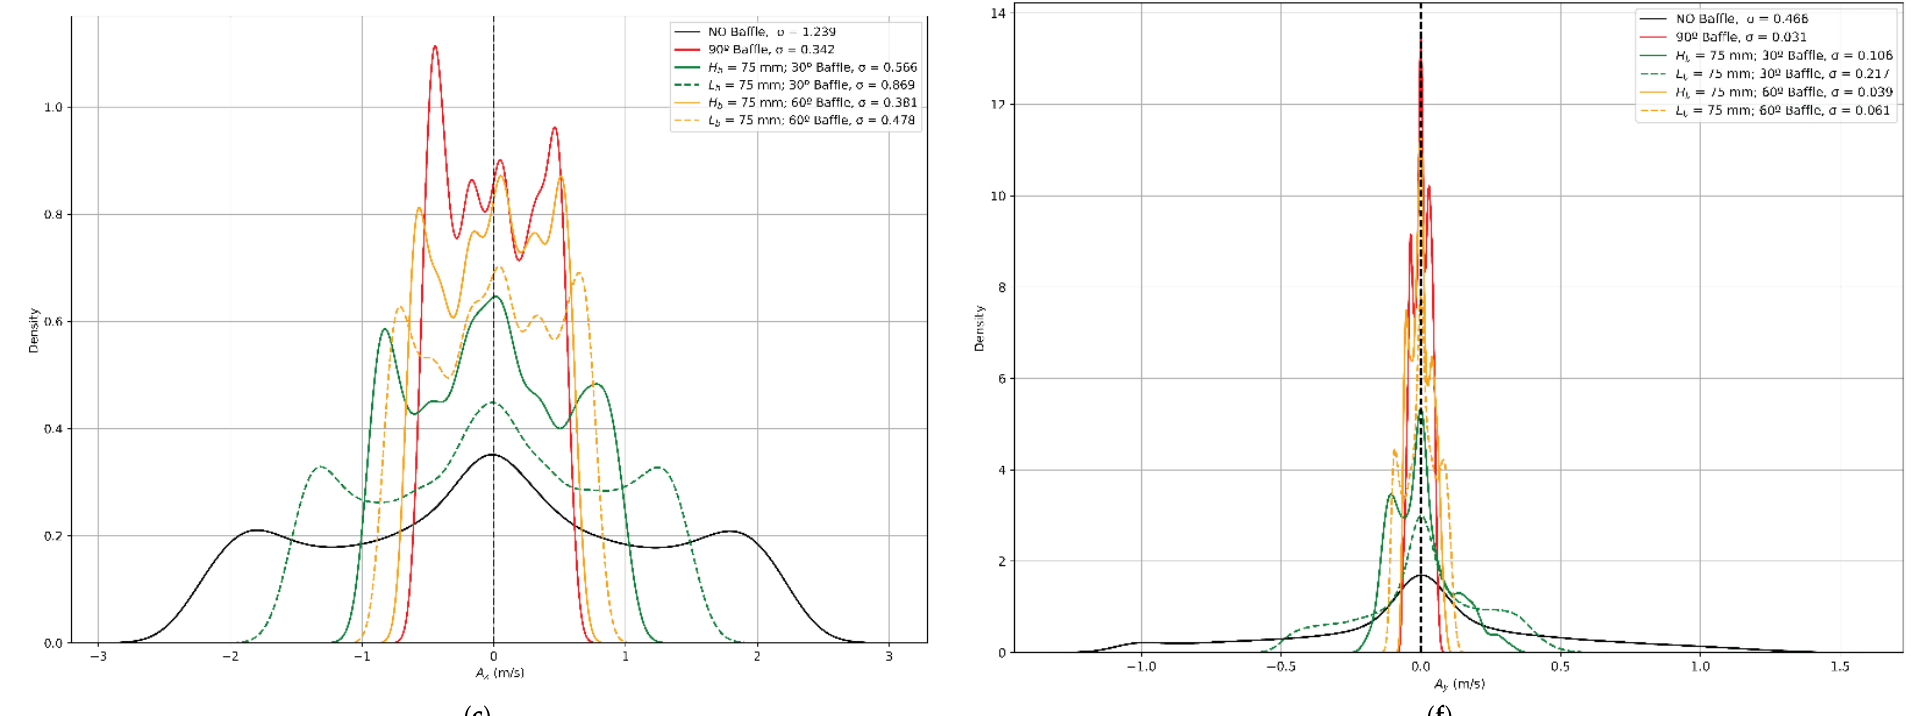
Figure 9. Kernel density distribution. Left column for fixed H b = 75 mm ( a ) CG position, ( b ) velocity and ( c ) acceleration in X direction and right column for fixed L b = 75 mm ( d ) CG position, ( e ) velocity and ( f ) acceleration in Y